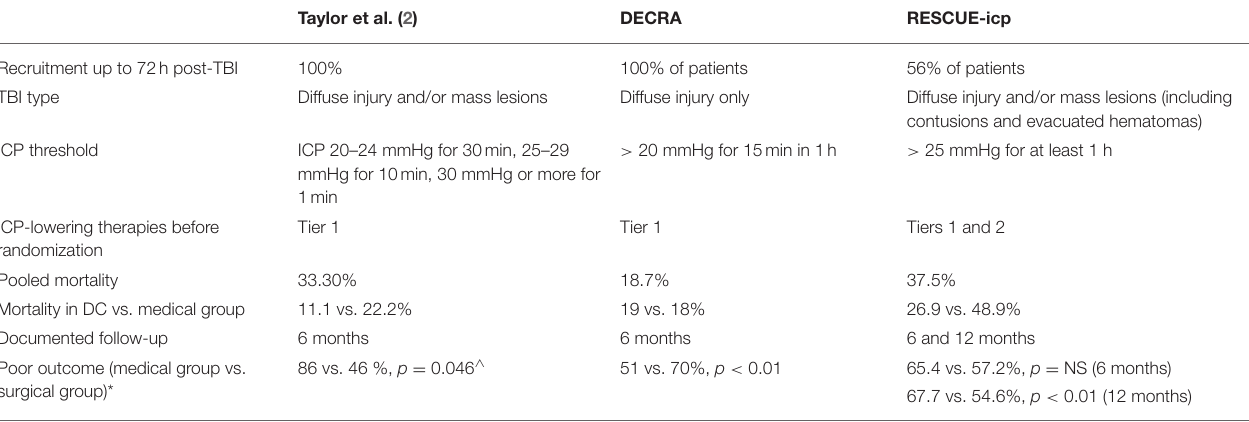
Poor outcome (medical group vs. surgical